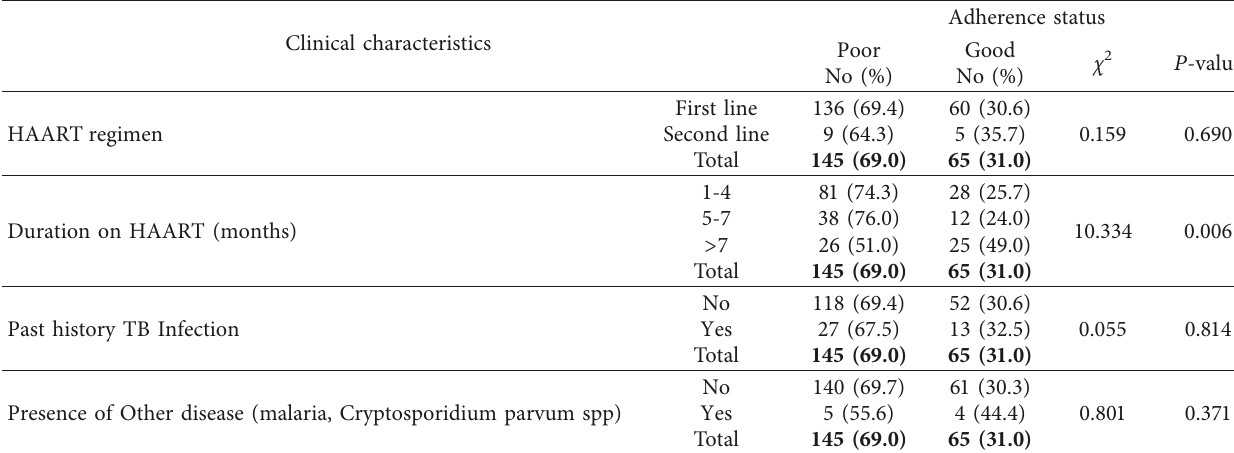
Table 5: Adherence to ART treatment and clinical characteristics among participants from the Buea and Kumba